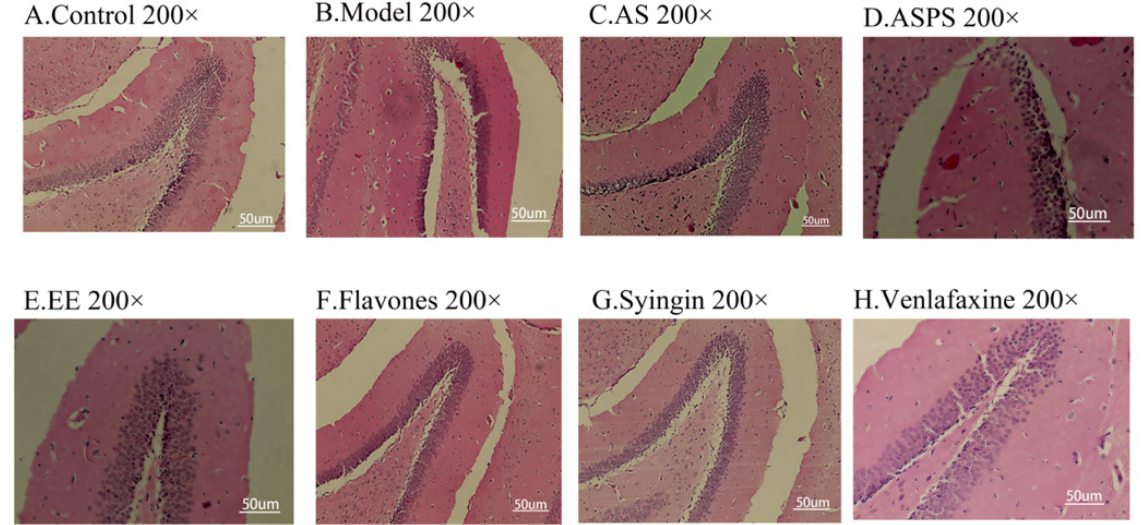
Figure 2. Histopathological sections of hippocampus in different groups of mice: ( A ) Control group; ( B ) Model group; ( C ) AS group; ( D ) ASPS group; ( E ) EE group; ( F ) Flavones group; ( G ) Syringin group; ( H ) Venlafaxine group. (Three mice were used in this analysis and the representative pictures were shown, scale bar = 50 um).